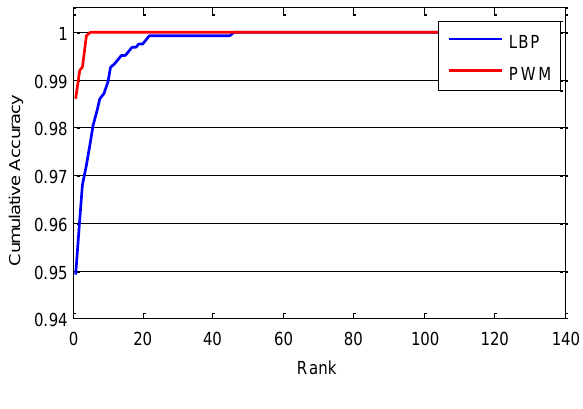
Figure 10. Cumulative match curves by different